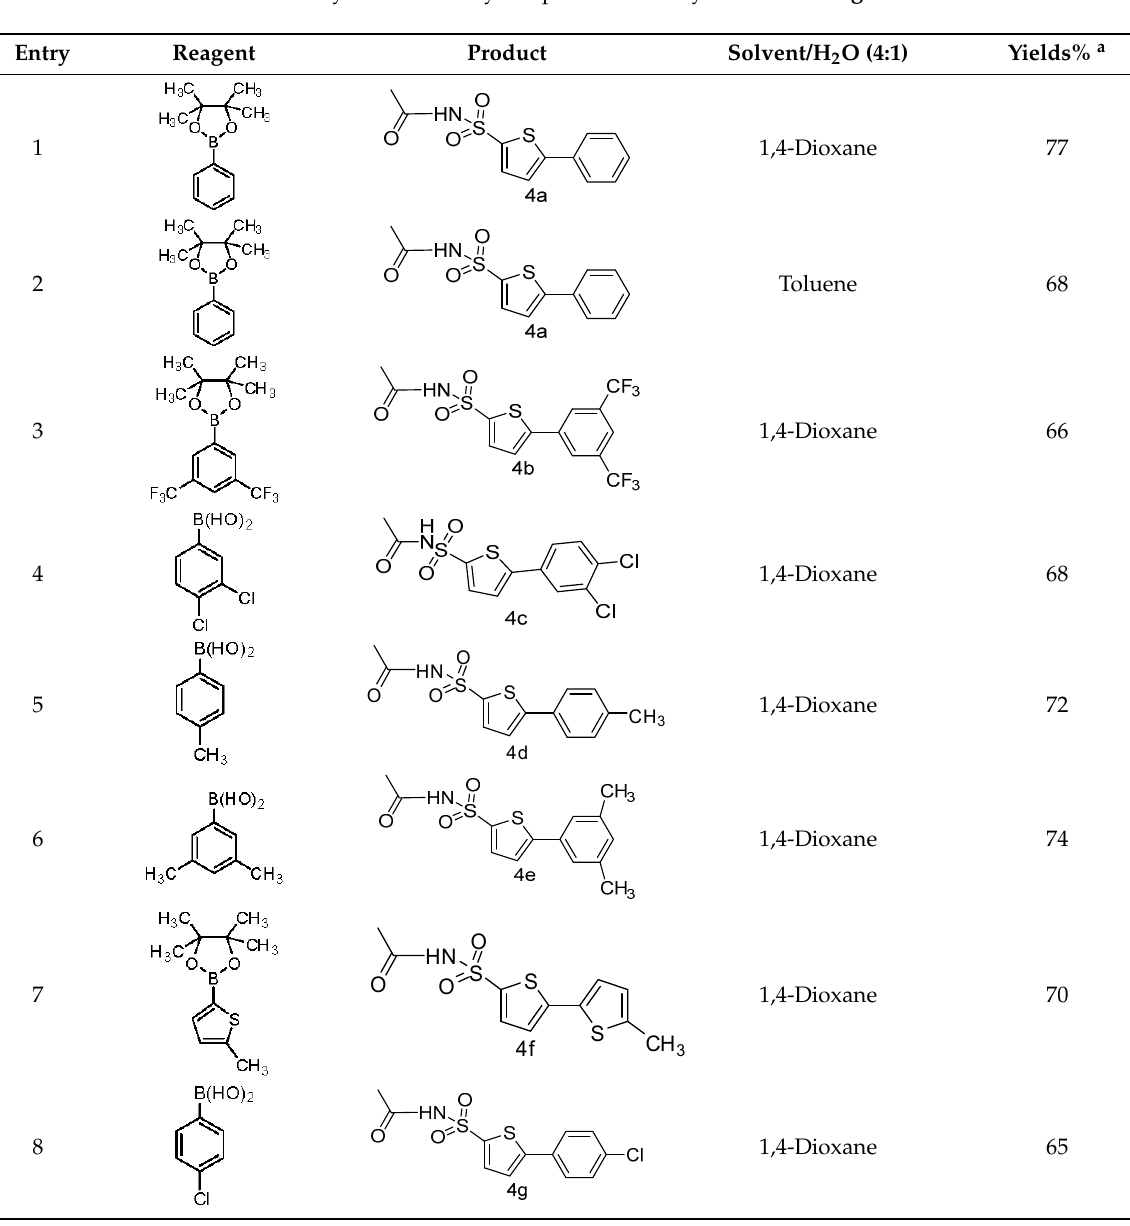
Molecules 2015 , 20 Table 1. Synthesis of 5-arylthiophene-2-sulfonylacetamide 4a – g . Table 1. Synthesis of 5-arylthiophene-2-sulfonylacetamide 4a – g . Table 1. Synthesis of 5-arylthiophene-2-sulfonylacetamide 4a – g . Table 1. Synthesis of 5-arylthiophene-2-sulfonylacetamide 4a – g . Table 1. Synthesis of 5-arylthiophene-2-sulfonylacetamide 4a – g Table 1. Synthesis of 5-arylthiophene-2-sulfonylacetamide 4a – g . Table 1. Synthesis of 5-arylthiophene-2-sulfonylacetamide 4a – g . Table 1. Synthesis of 5-arylthiophene-2-sulfonylacetamide 4a – g . Table 1. Synthesis of 5-arylthiophene-2-sulfonylacetamide 4a – g . Table 1. Synthesis of 5-arylthiophene-2-sulfonylacetamide 4a – g . Table 1. Synthesis of 5-arylthiophene-2-sulfonylacetamide 4a – g . Table 1. Synthesis of 5-arylthiophene-2-sulfonylacetamide 4a – g . Table 1. Synthesis of 5-arylthiophene-2-sulfonylacetamide 4a – g . Table 1. Synthesis of 5-arylthiophene-2-sulfonylacetamide 4a – g .